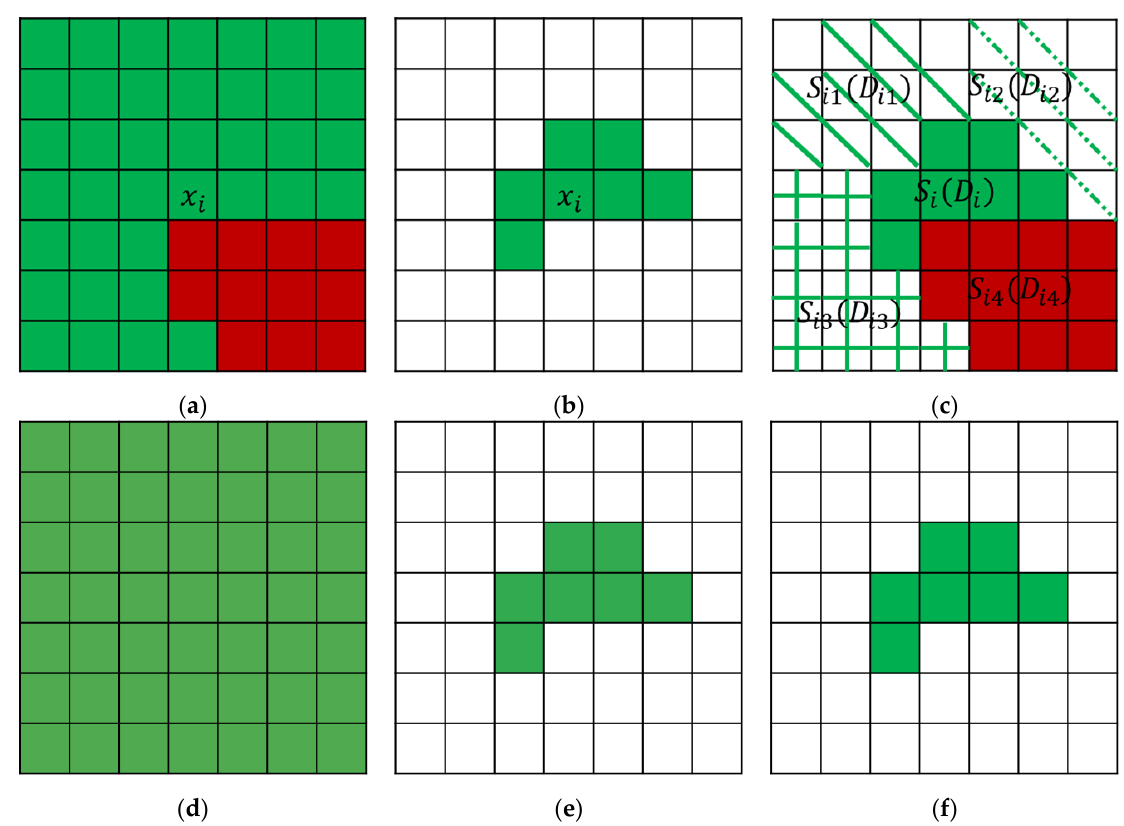
Figure 1. Different spatial region selection. ( a ) Square; ( b ) Superpixel; ( c ) Weighted adjacent superpixels (ASs). ( d ) Features of square region; ( e ) Features of superpixel region; ( f ) Features of weighted ASs region. Note that the greener the color in ( d , e , f ), the more accurate the features.